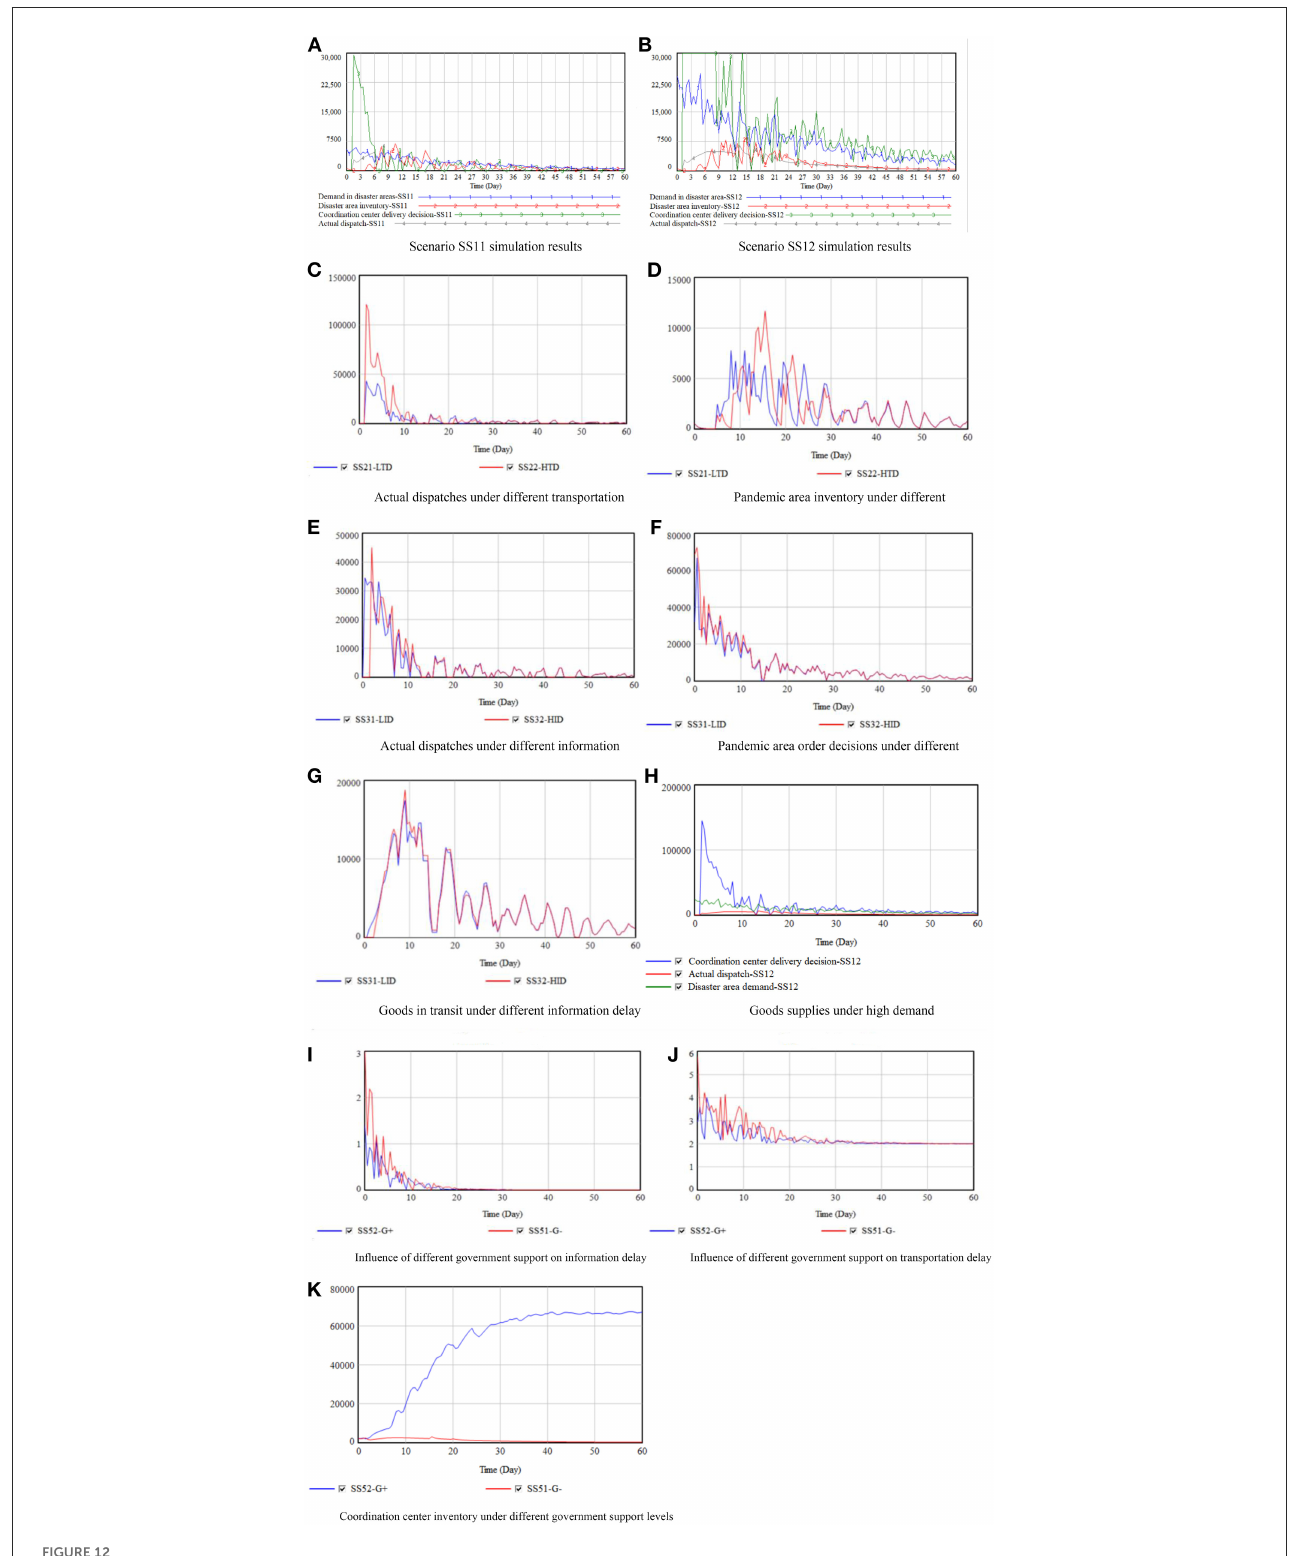
FIGURE12 Goods supply simulation results.